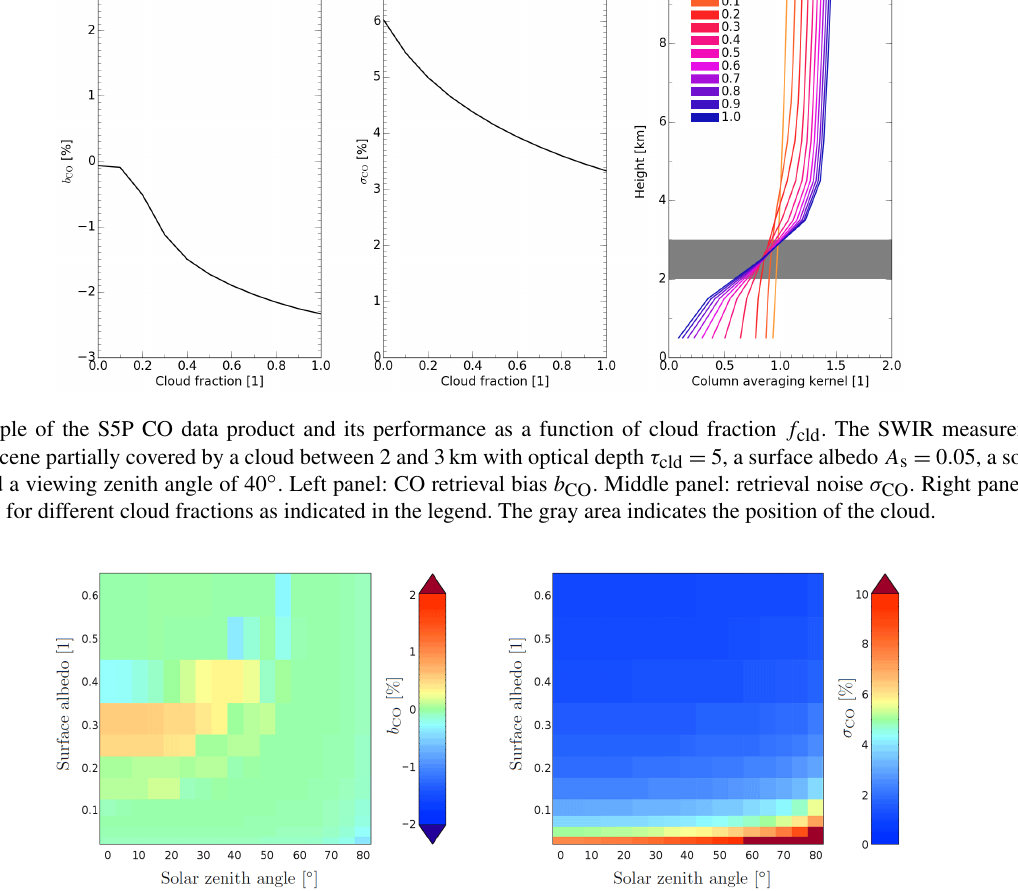
Figure 5. Retrieval bias b CO (left panel) and retrieval noise σ CO (right panel) for the clear sky conditions (without aerosol, clouds and cirrus) and for a viewing zenith angle (VZA) of 0 ◦ as a function of solar zenith angle (SZA) and surface albedo A s